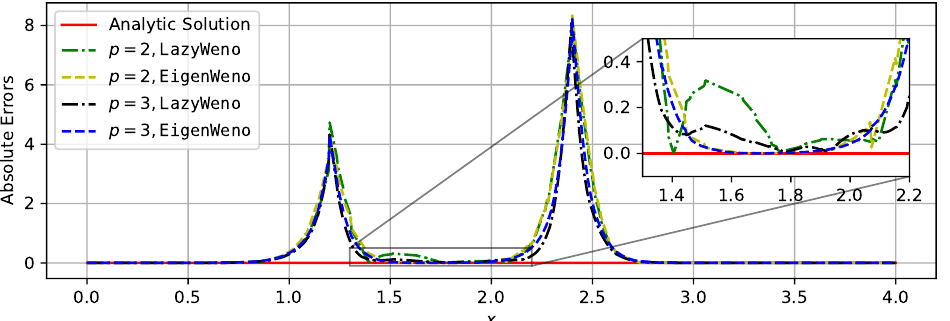
Figure 11. Comparison between absolute errors of numerical solutions in Figures 9 and